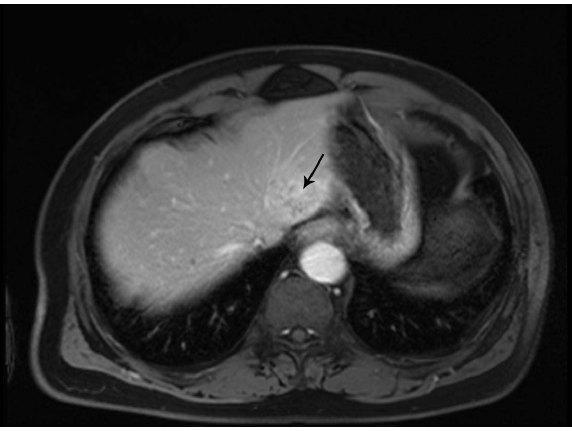
Figure 1: Abdominal magnetic resonance imaging findings. A cont- rast-enhanced T1W MRI showed a single, round, hypodense lesion with peripheral contrast enhancement in the left lobe of the liver.